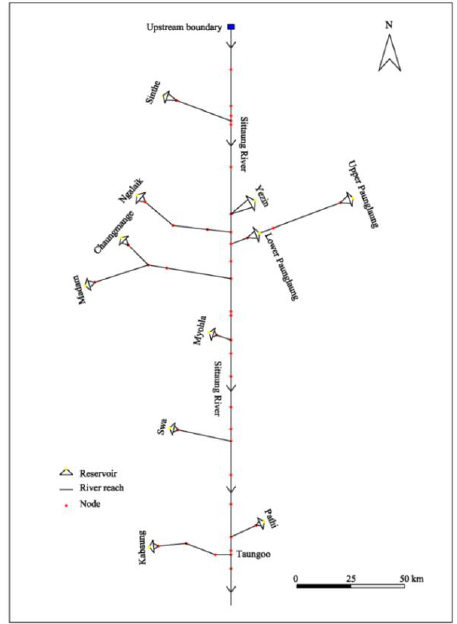
Figure 3. A schematic diagram of the simplified internal model.